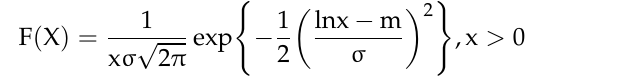
Figure 3. Definition of input parameters before running the simulation. The application provides different representations of the simulation model — logical (Figure 2) as well as 2D (Figure 4a) and 3D (Figure 4b). ( a ) ( b )